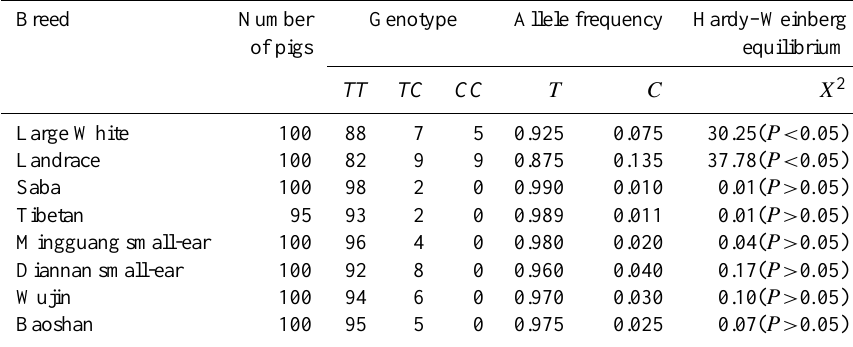
Table 2. Allele frequency of the SPATS2L gene in eight pig breeds.